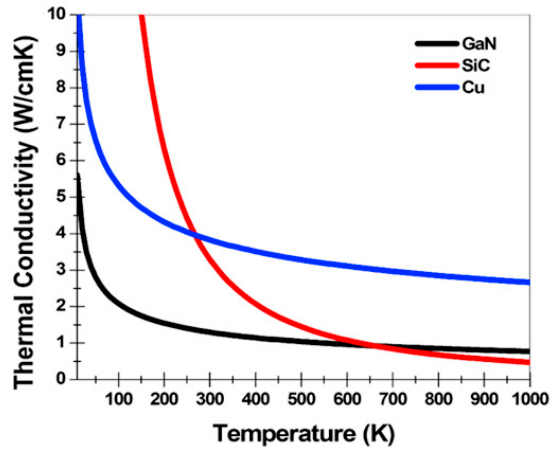
Figure 7. Thermal conductivity profiles for GaN, SiC, and Cu. At the highest recorded temperature of 1000 K, SiC has the lowest thermal conductivity, followed by GaN and Cu. Reprinted with permission from ref. [137]. Copyright 2020 MDPI.